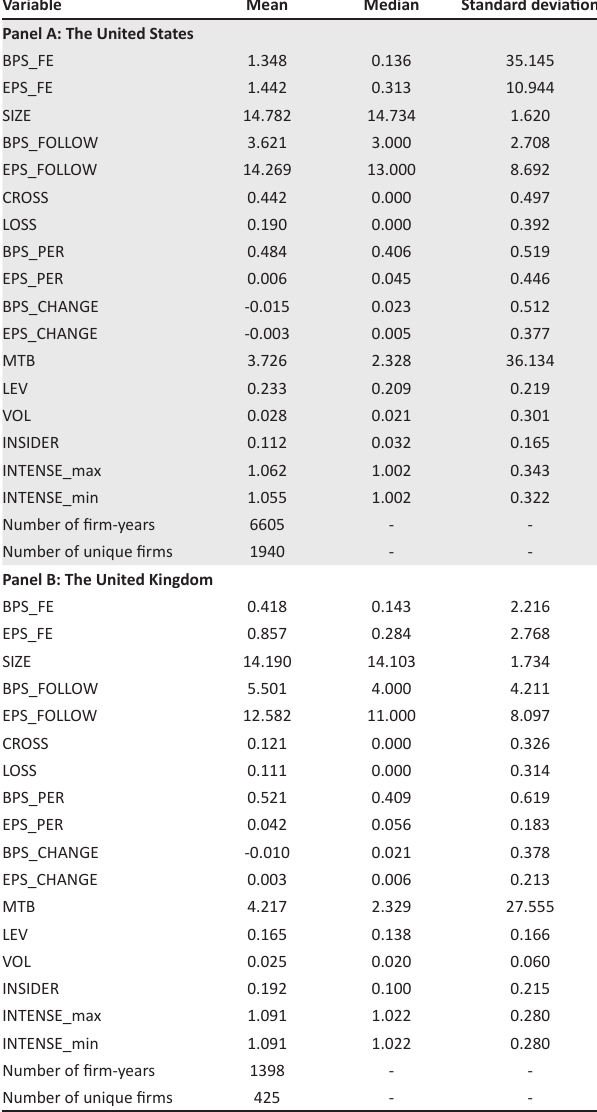
TABLE 1: Sample numbers and descriptive statistics. Variable